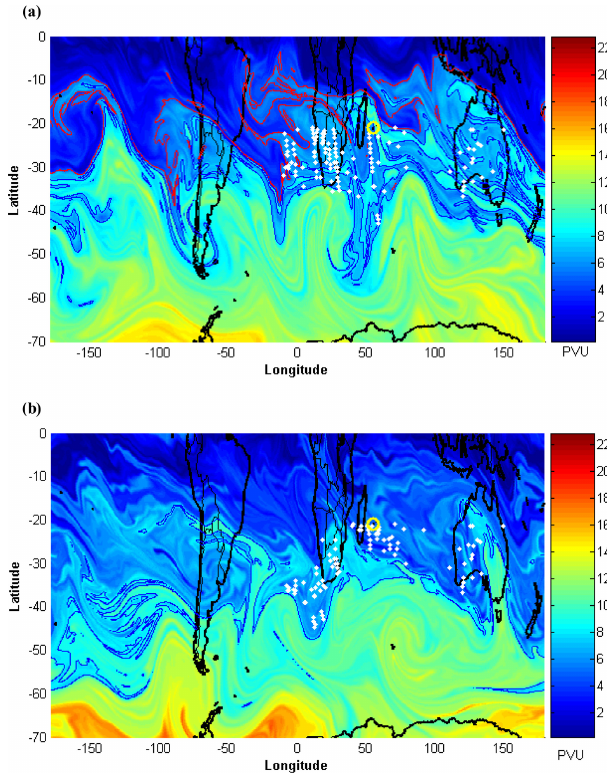
Figure 12. Same as Fig. 11 but for (a) 19 May 2015 and (b) 3 June